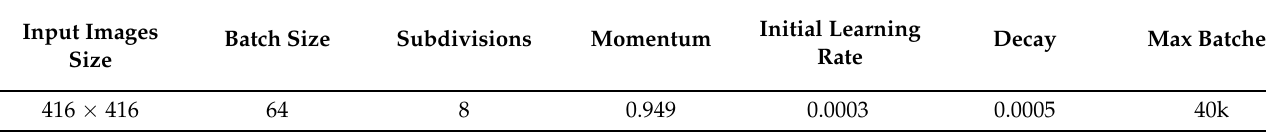
Table 2. Main parameters used to train